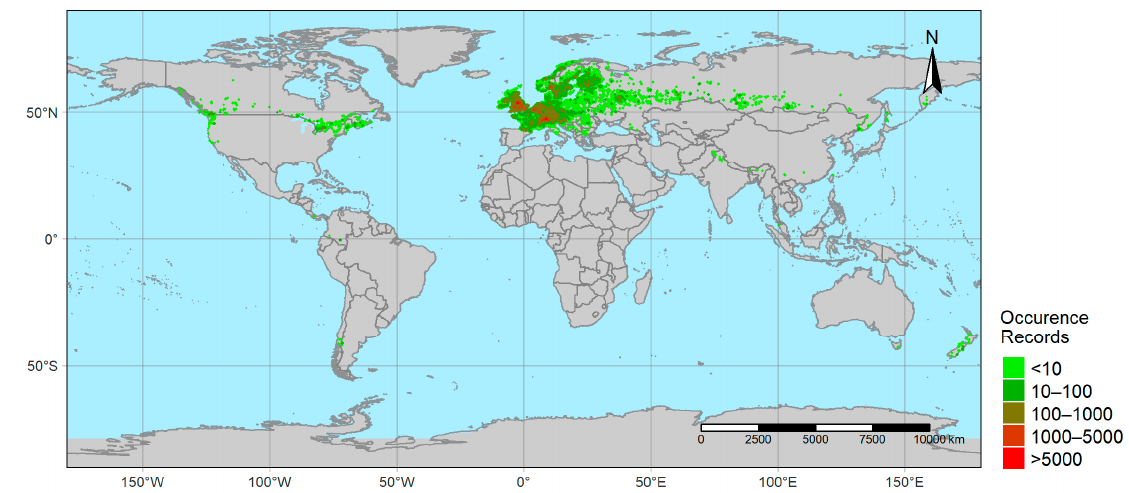
Figure 1. Occurrence records of Impatiens glandulifera (based on GBIF data).